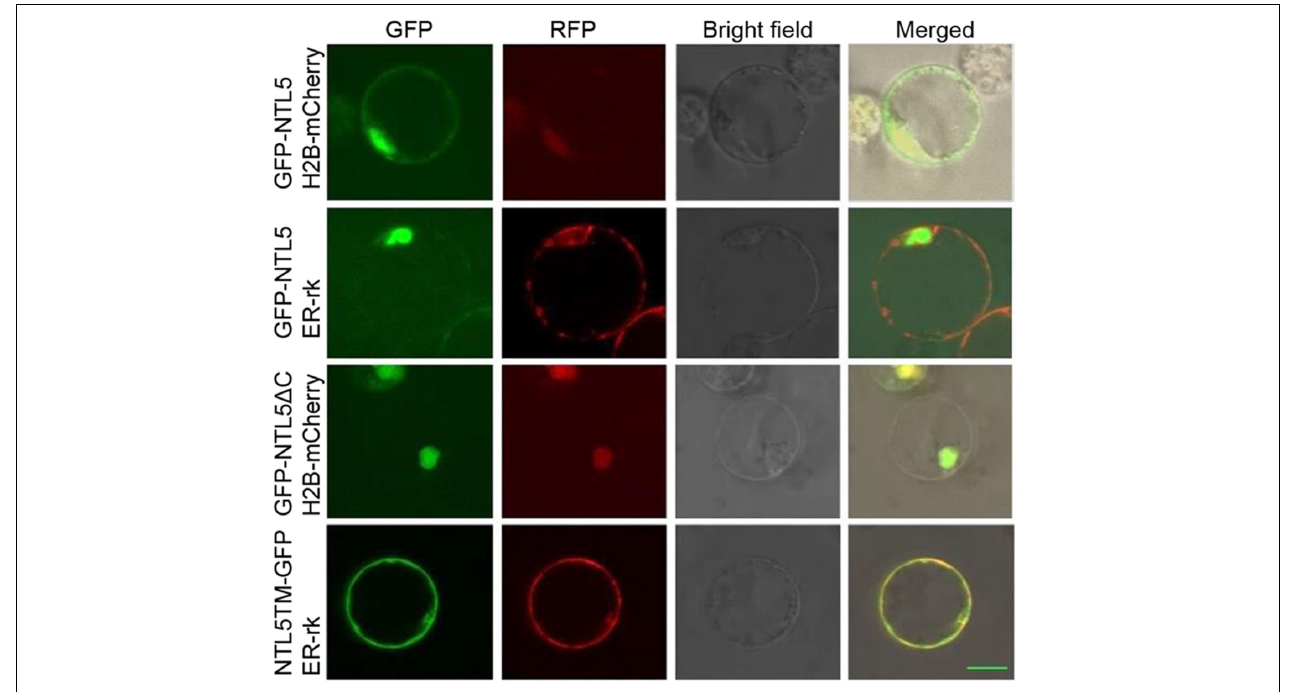
FIGURE 2 | Subcellular localization of OsNTL5, OsNTL5 (cid:49) C, and OsNTL5TM in protoplasts of rice. Confocal images of cells expressing GFP-OsNTL5, GFP-OsNTL5 (cid:49) C, and NTL5TM-GFP. Nuclear marker protein (H2B-mCherry) and ER marker protein (ER-rk) were co-expressed respectively in rice leaf protoplasts by PEG (polyethylene glycol) treatment. Fluorescence was observed using a Zeiss LSM 710 confocal microscope. TM, transmembrane domain. Bar = 10 µ m.